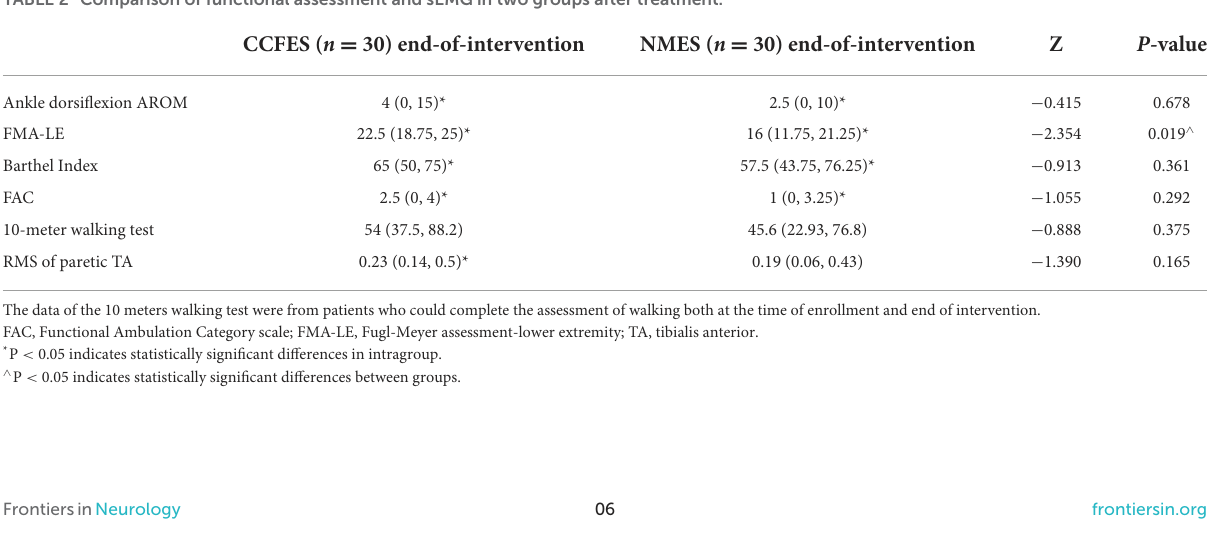
TABLE 2 Comparison of functional assessment and sEMG in two groups after